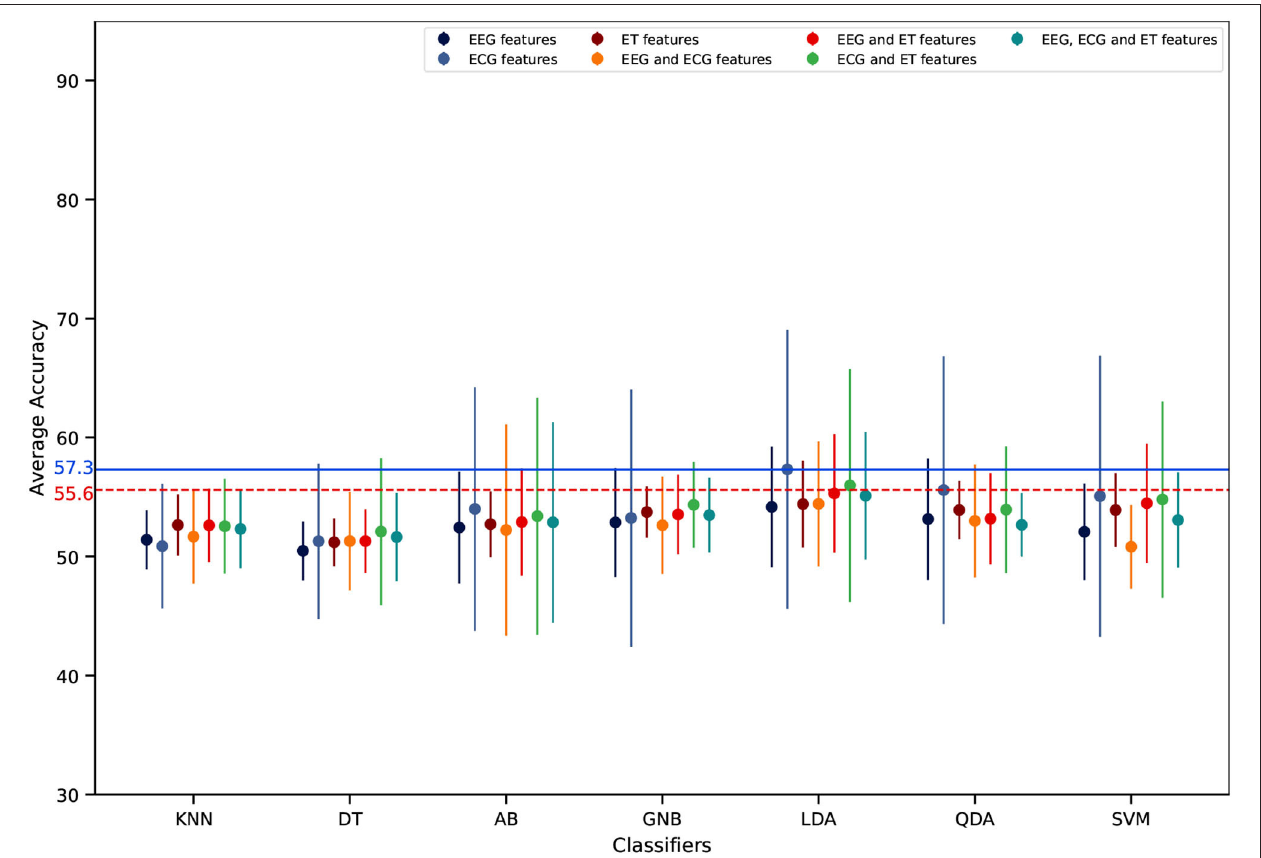
FIGURE 13 | Inter-subject mental workload estimation results per features and classifiers with the traditional validation design (average across participants). The dots represent the average score of each feature combination and the vertical line represents the associated standard deviation. The dashed horizontal red line represents the adjusted chance level while the blue one represents the highest classification